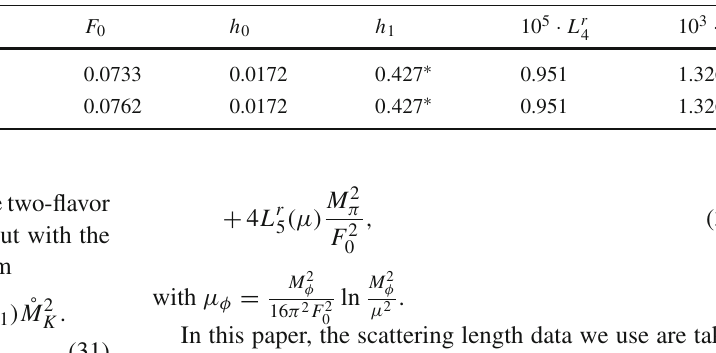
and L r are fixed by the data in Ref. [25]. The masses and decay 4 5 and L r are dimensionless. The asterisk indicates an input 4 5